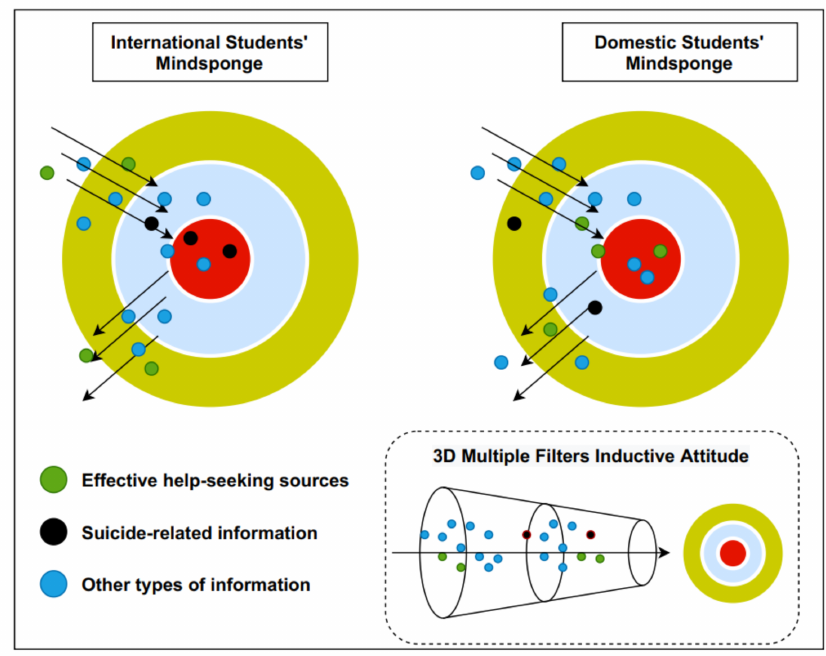
Figure 1. The Mindsponge process of suicidal ideation and help-seeking